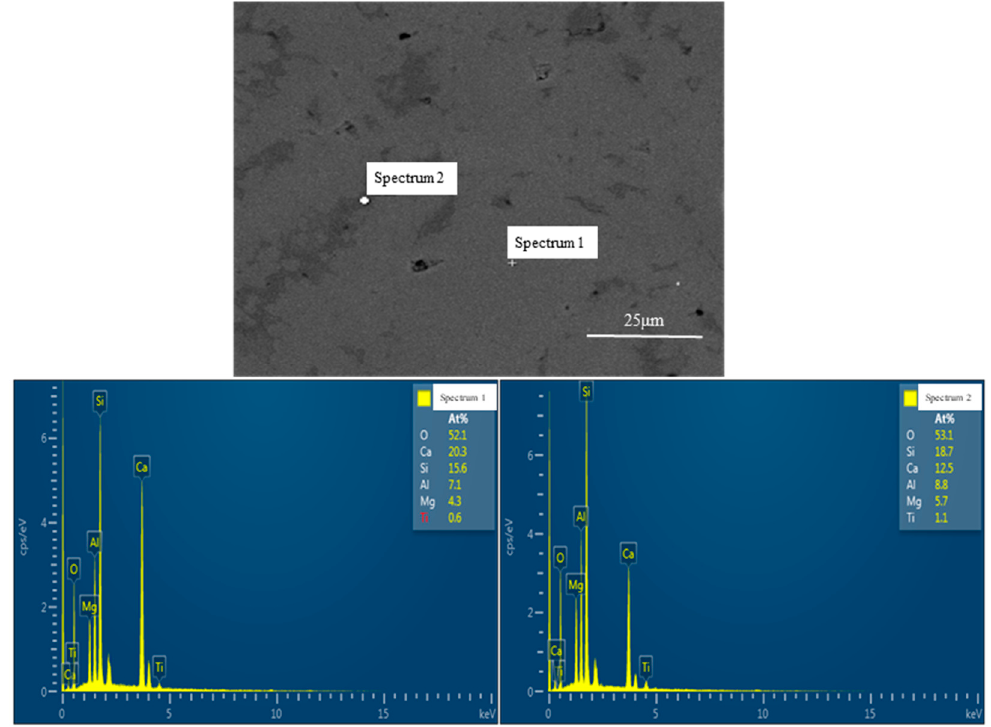
Figure 10. SEM image of a sample with 2% TiO 2 , with EDS analysis overlaid on the photographs.